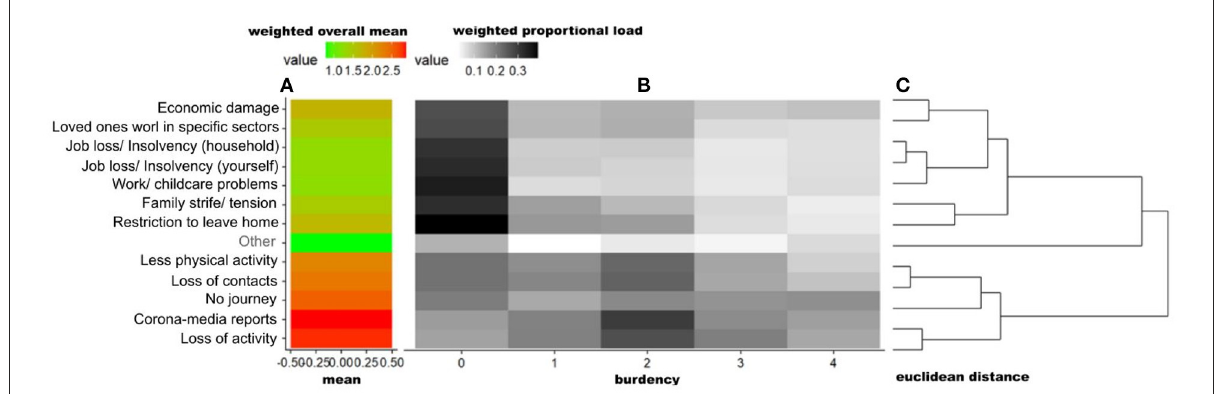
FIGURE3 DH bs Heat Map, indicating the burden’s mean of stressors (weighted DH bs ) vertically clustered by their burden patterns. The figure consists of three parts: (A) showing the weighted overall mean of each item. (B) illustrates the weighted proportional load with which a particular stressor was experienced–the darker the background, the more burdensome the stressor was experienced (from “not at all burdensome” to “very burdensome” on a five-point Likert scale). For example, “media-corona reports” were experienced by many respondents as burdensome (average severity rating mean: 2.88). (C) Dendrogram indicating the difference between the items and their clusters of patterns of relative burden. This cluster solution was also used to vertically sort the stressor items (using hierarchical clustering, euclidean distance and complete linkage). The proportional burden of each item (e.g., loss of activity “not at all burdensome”: 13%, …, “very burdensome” 10%) are successively merged into clusters. The fusion of different clusters is marked in the dendrogram by vertical lines. The heterogeneity within the clusters is plotted on the x-axis, it is growing with increasing cluster size. Longer horizontal lines indicate an increase in heterogeneity (of clusters) between the temporal occurrence patterns of the items: Cluster A includes 7 items (“economic damage” to “restriction to leave home”). Cluster B includes “Other” with answers concerning additional problems (“Goods & services problems”, “Burden due to mandatory masks”, “Deterioration of mental situation” or “Digital study/school”), fears (“Second wave”, “economic impact/lockdown”, “Social change”, “Infection itself/others” and “Further measures”) and anger (“Ignoring measures/recklessness”, “Measures/policy” and “Media reporting”). Cluster C includes 5 items (“Less physical activity” to “loss of